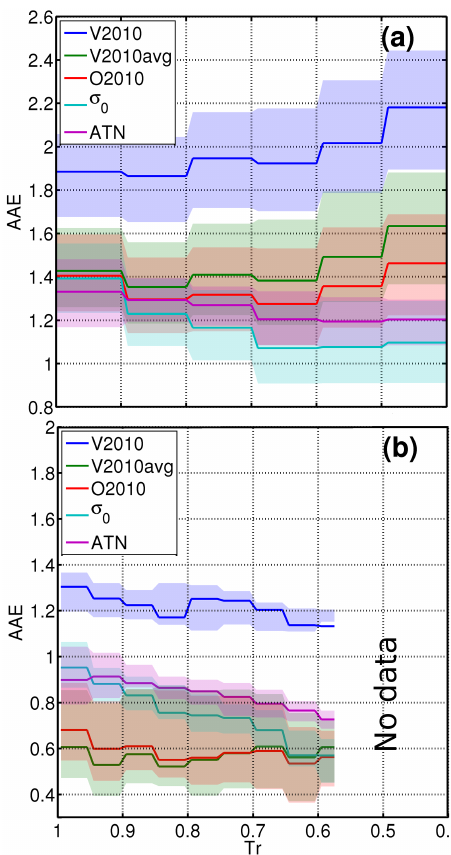
Figure 5. AAEs calculated using different correction algorithms, σ 0 , and the AAEs calculated from ATN as a function of Tr. The solid lines represent the median AAE for the different corrections, σ 0 and ATN. The lines are ramped to indicate the Tr range the median was calculated from. The shaded coloured areas show the 25th to 75th percentile range of the AAEs lines with the same color. Panel (a) is based on Elandsfontein data and (b) is based on NEAQS 2002 campaign data. During the NEAQS 2002 campaign, the filter was changed at higher filter transmittances than at Elandsfontein. Hence there is no data when Tr < 0.575.